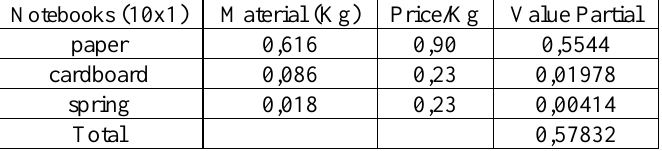
Table 1: Demonstration of values in the sale of waste.